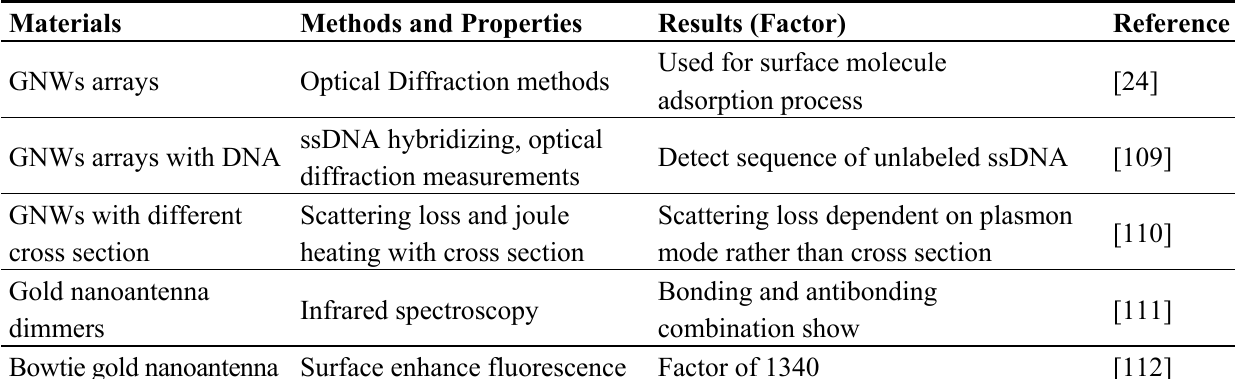
Table 7. List of the flowing resent researches on optical properties of GNWs